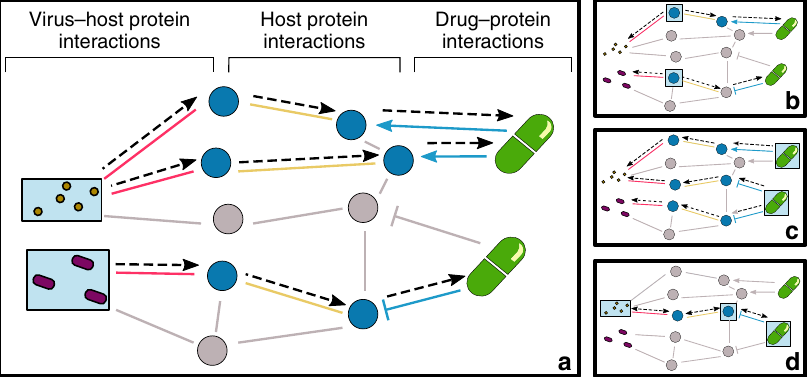
Fig. 3 CoVex application scenarios. Depending on the starting hypothesis, dedicated systems medicine algorithms will propagate from selected seeds to connect drugs with viral proteins using host proteins as proxies. Essentially, four different strategies apply: a Starting with viral proteins, one can identify drugs targeting host proteins that connect the viral seeds. b Starting with a set of proteins of interest as proxies, we identify pathways connecting them to